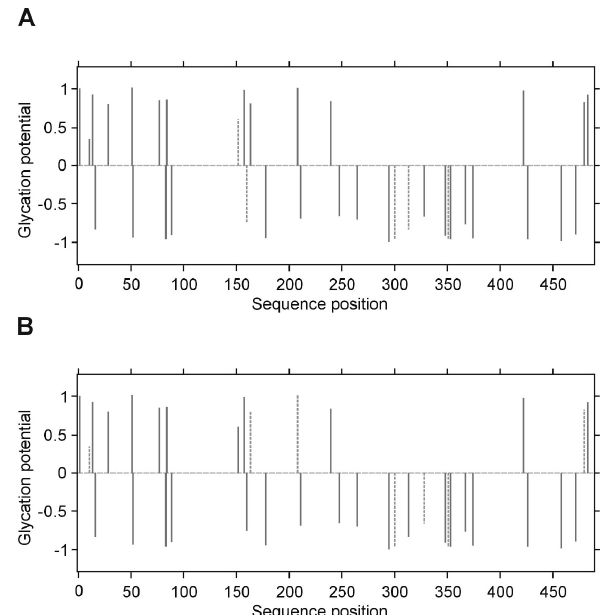
Figure 8. Predicted glycation sites in the β chain of human fibrinogen, evaluated by NetGlycate v1.0 software. Each plot presents the scores of glycation potential (bars), given for all 36 Lys residues of the β chain in control volunteers ( A ) and diabetic patients ( B ), which are relevant to the numbers between − 1 and 1 (threshold marked as grey dashed line); a score above 0 means that the residue is a predicted glycation site, while a score below 0 means that the residue is unlikely to be glycated. The bars marked by dashed thick lines denote the residues that were found to be really glycated in the examined subjects.